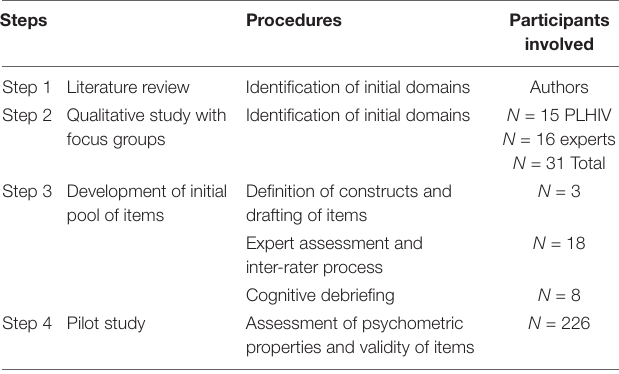
TABLE 1 | Summary of research